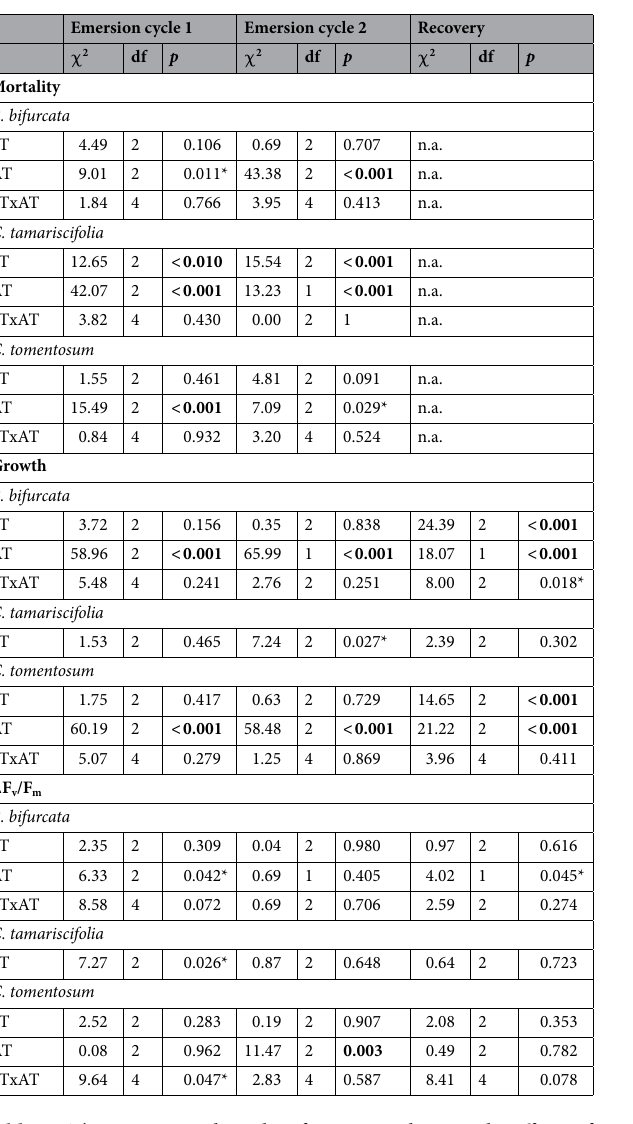
Table 1. The summarised results of GLMs used to test the effects of seawater (ST) and air temperature (AT) on the mortality, growth and ΔF v /F m of fronds after the emersion cycles and during the recovery period, in the laboratory experiment. Significant effects ( p < 0.01) are indicated in bold. * indicates marginal significance. “n.a.” indicates not analysed as no mortality was recorded in the recovery period. Note that due to an insufficient number of replicates, the effect of the extreme atmospheric heatwave (35.7 °C) on the growth and the ΔF v /F m of B. bifurcata after the second emersion cycle was not modelled. Likewise, the effect of air temperature on the growth and the ΔF v /F m of C. tamariscifolia after the cycles of emersion were not